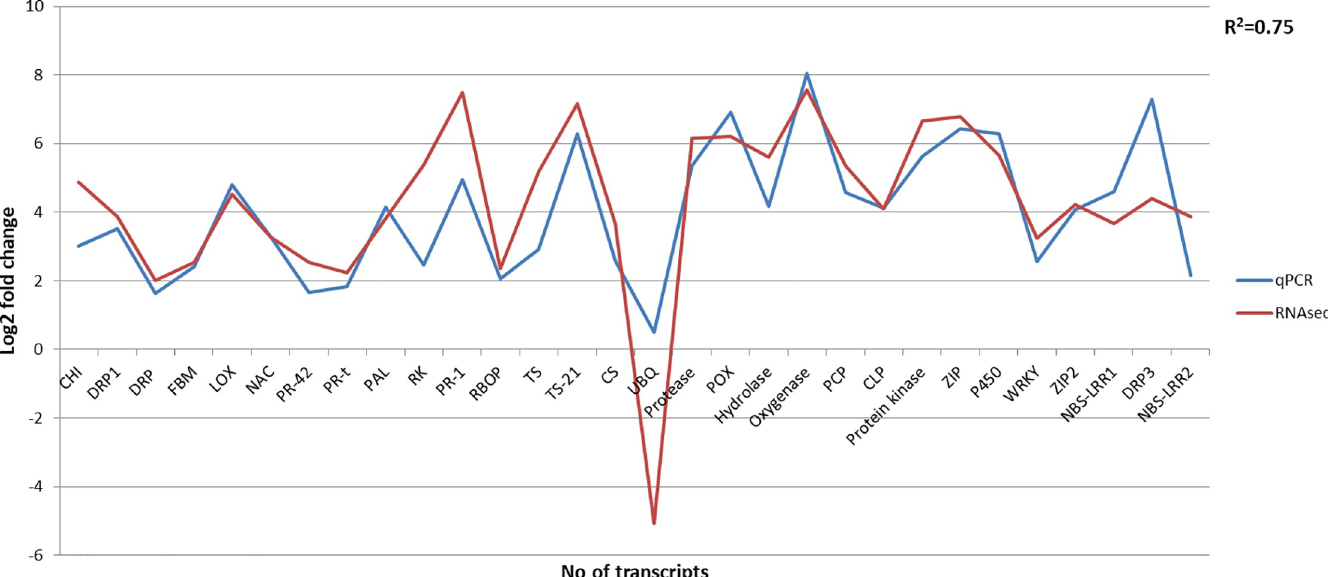
Fig 5. Correlation between differentially expressed transcripts from RNA-Seq and qPCR data for 30 genes.